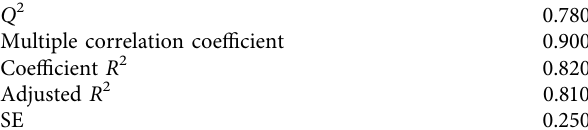
Table 7: LOO cross-validation statistics for model 02.